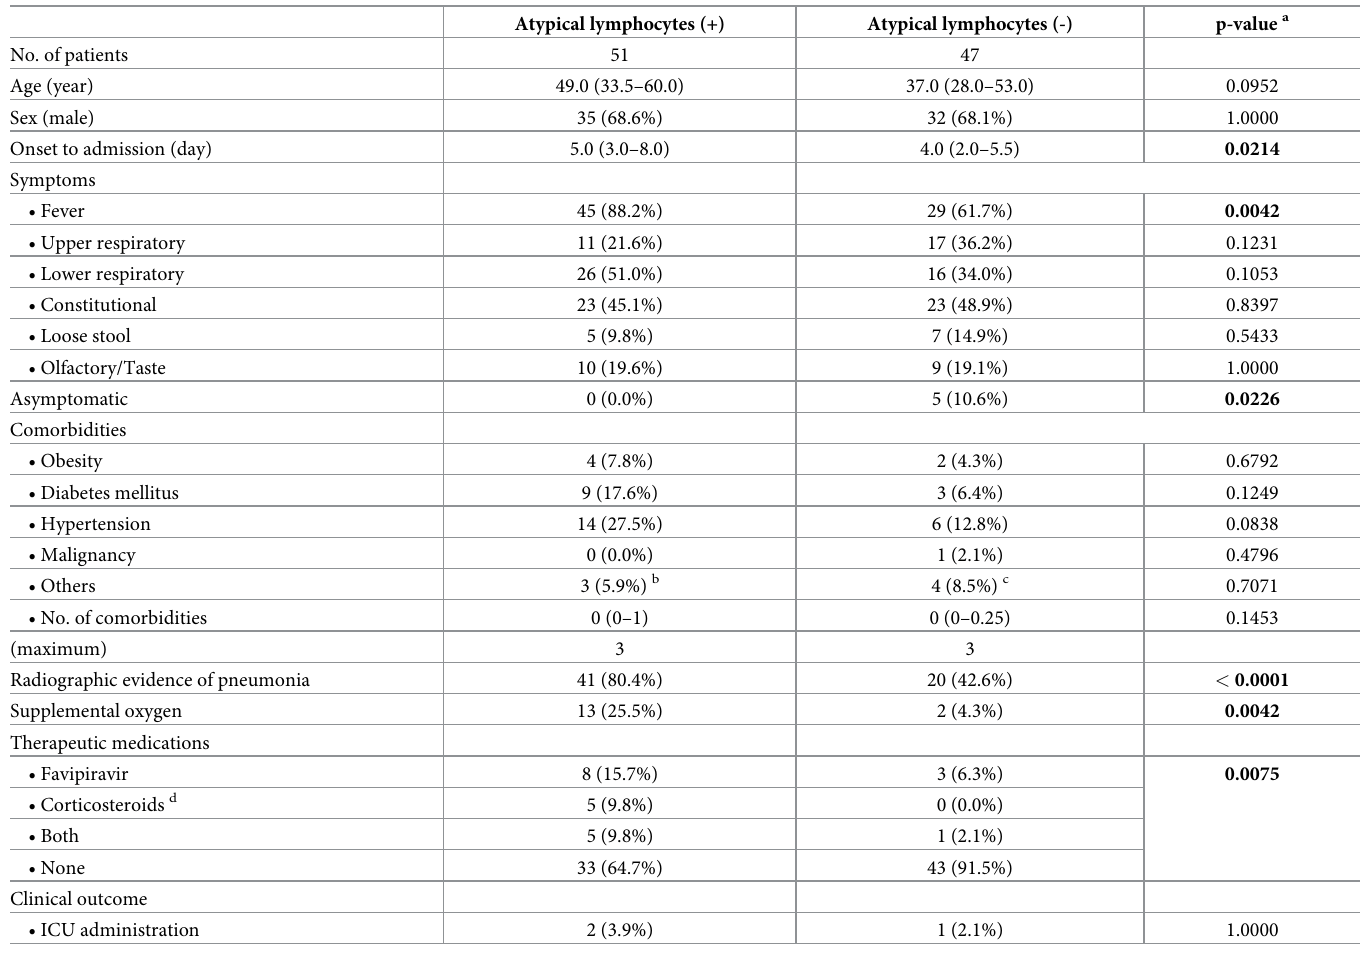
Table 1. Patient